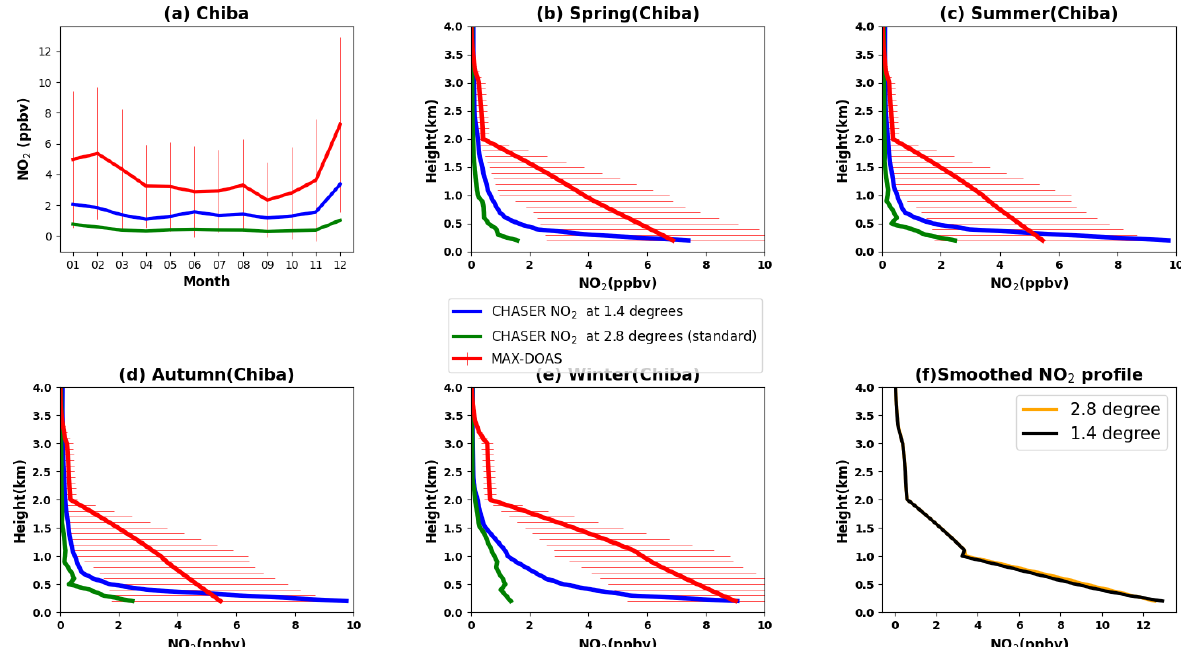
Figure 12. (a) Seasonal variations in the NO 2 mixing ratios in the 0–2km layer at Chiba, as inferred from the MAX-DOAS observations (red) and two CHASER simulations at 2.8 ◦ (green) and 1.4 ◦ (blue) resolutions. The simulated NO 2 profiles at 2.8 ◦ (green) and 1.4 ◦ (blue) resolutions during (b) spring, (c) summer, (d) autumn, and (e) winter are shown with the observed seasonal profiles at Chiba. Only data (both observed and simulated) for 2018 are plotted. The coincident time and date between the model and observations are selected only. The error bars in (a) , (b) , (c) , (d) , and (e) represent the 1 σ standard deviation of mean values of the MAX-DOAS observations. (f) CHASER simulations at 2.8 ◦ (orange) and 1.4 ◦ (black) smoothed with MAX-DOAS AKs.